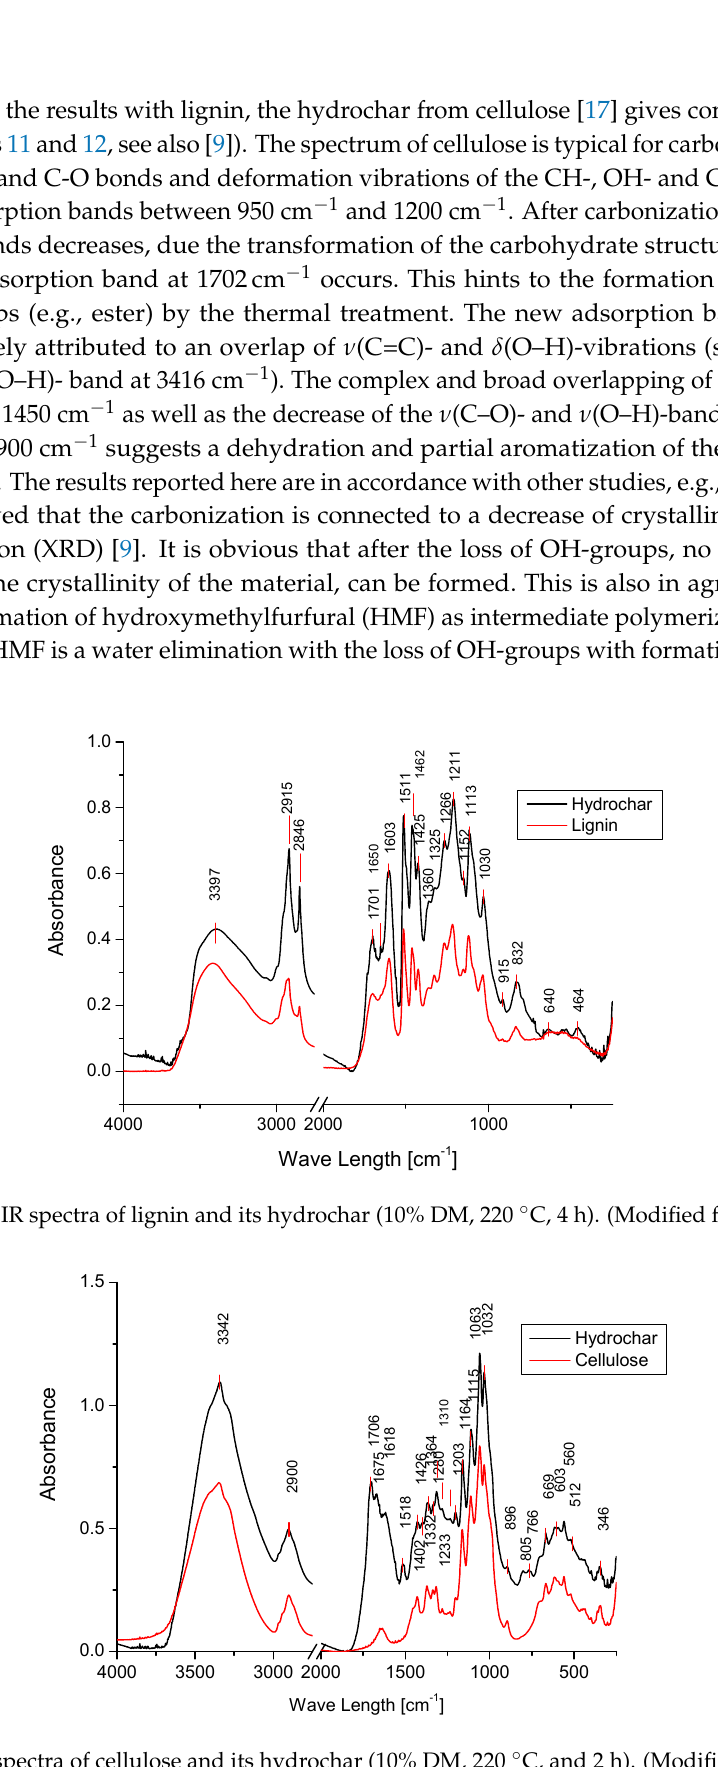
Figure 11. IR spectra of cellulose and its hydrochar (10% DM, 220 °C, and 2 h). (Modified from [21]). Comparing the hydrochar IR spectrum from cellulose produced at 220 °C (Figure 11) with that of the hydrochar produced at 250 °C (Figure 12), the decrease of the typical carbohydrate vibration bands is obvious. This is in line with the DTG measurement of the lignocellulosic biomasses (Figure 5 and Figure 6): with increasing HTC-temperatures, a larger amount of cellulose is carbonized (see also [4]).